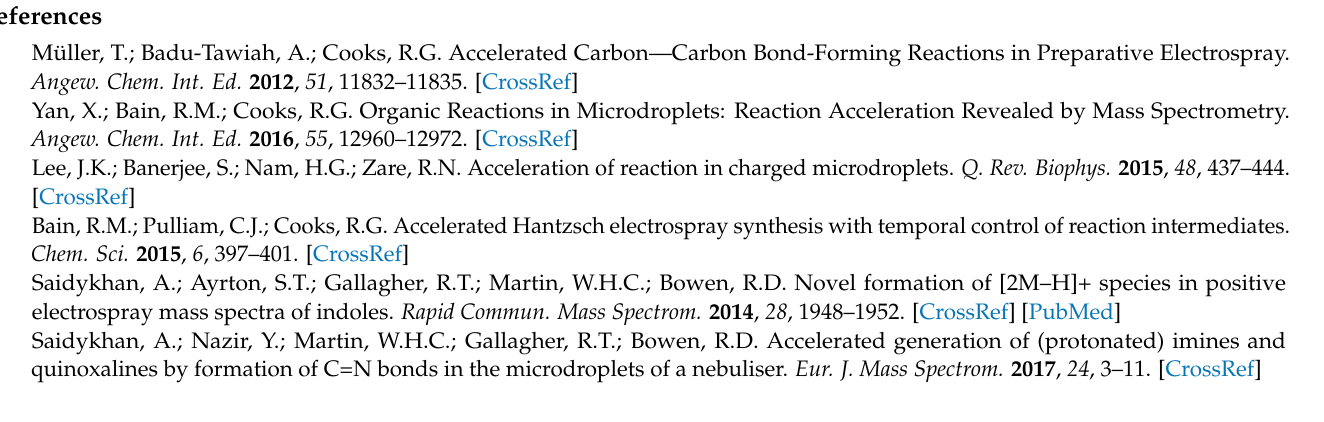
Peak information for competition of P , B and Cl 2 P ; Figure S5: Chromatogram for competition of P , B and BrP ; Table S5: Peak information for competition of P , B and BrP ; Figure S6: Chromatogram for competition of P , B and Br 2 P ; Table S6: Peak information for competition of P , B and Br 2 P ; Figure S7: Chromatogram for competition of P , B and CH 3 P ; Table S7: Peak information for competition of P , B and CH 3 P ; Figure S8: Chromatogram for competition of P , B and (CH 3 ) 2 P ; Table S8: Peak infor- mation for competition of P , B and (CH 3 ) 2 P ; Figure S9: Chromatogram for competition of P , B and CH 3 OP ; Figure S10: Chromatogram for competition of P , B and CF 3 P ; Table S10: Peak information for competition of P , B and CF 3 P ; Figure S11: Chromatogram for competition of P , B and CH 3 O 2 CP ; Table S11: Peak information for competition of P , B and CH 3 O 2 CP ; Figure S12: Chromatogram for competition of P , B and NCP ; Table S12: Peak information for competition of P , B and NCP ; Figure S13: Chromatogram for competition of P , B and NO 2 P ; Table S13: Peak information for competition of P , B and NO 2 P ; Figure S14: Chromatogram for competition of P , (CH 3 ) 2 P , B and B4,4 (cid:48) F 2 ; Table S14: Peak information for competition of P , (CH 3 ) 2 P , B , B4,4 (cid:48) F 2